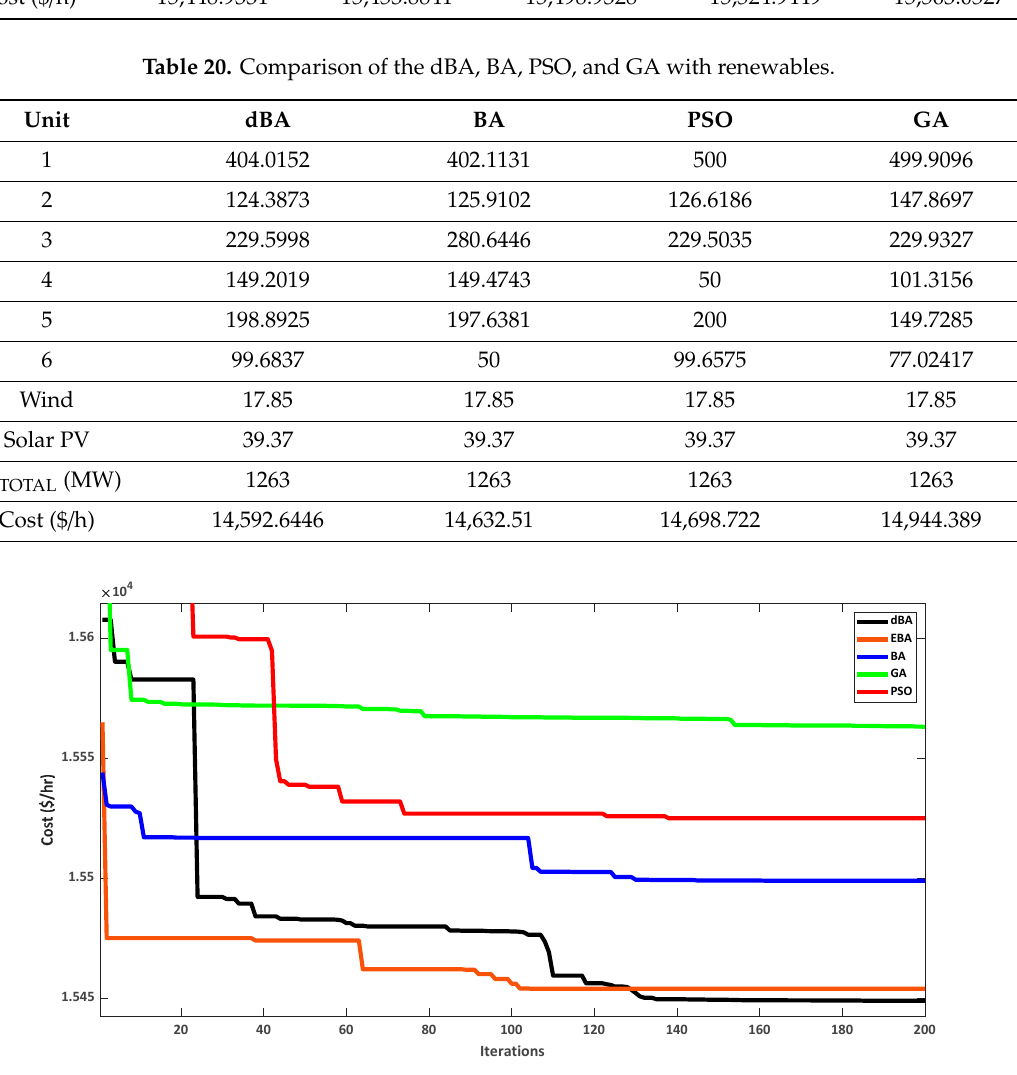
Figure 20. Cost convergence graph with valve point effect without renewables.